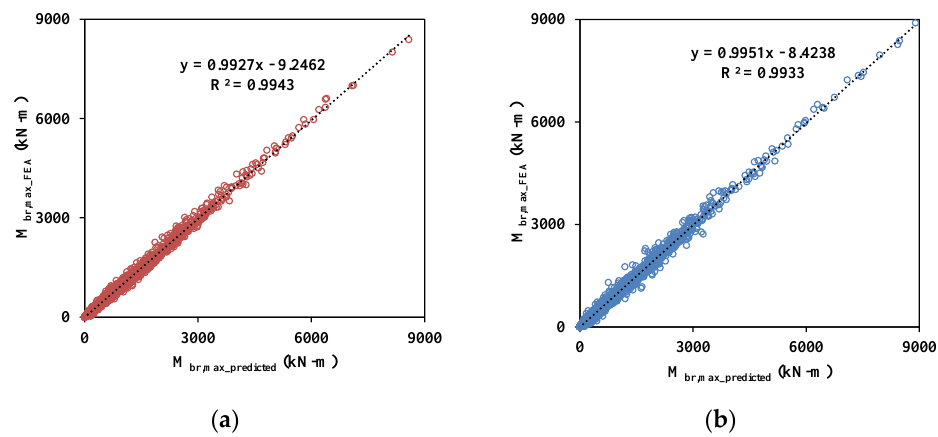
Figure 10. Comparisons of predicted maximum bracing moments ( M br , max ) of training and validation data sets: ( a ) training data and ( b ) test data.